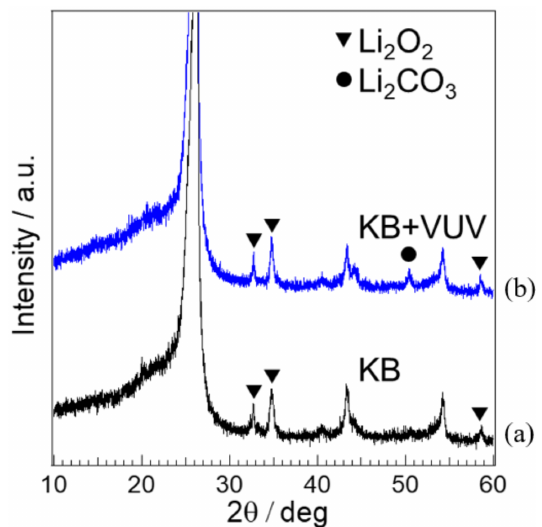
Figure 8. XRD patterns of (a) KB and (b) KB + VUV surfaces after the 1st discharge